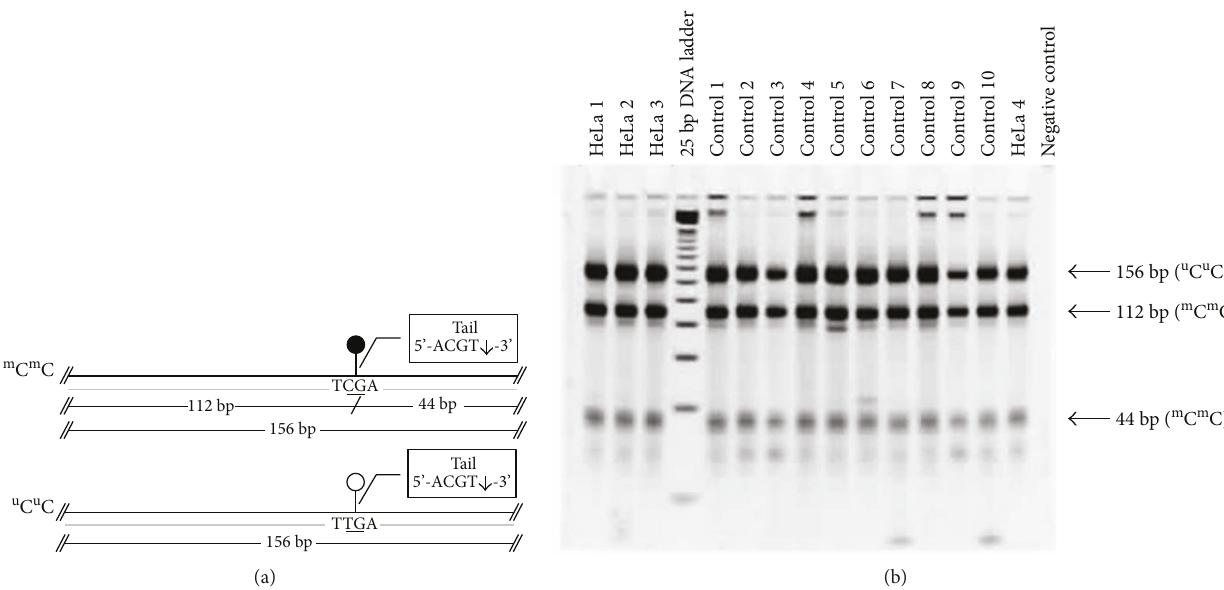
Figure 3: Combined-bisul fi te restriction analysis (COBRA) for HERV-K methylation patterns. The diagrams (a) demonstrate the following two patterns of methylated CpGs (from top to bottom): hypermethylation ( m C m C) and hypomethylation ( u C u C). Polyacrylamide gel electrophoresis (b) shows the locations for the bands for each pattern of methylated CpGs. Quantitative DNA ladder was used to assess the size of the bands. The representative gels of cell line and normal control samples are shown. Water is used as a negative control.